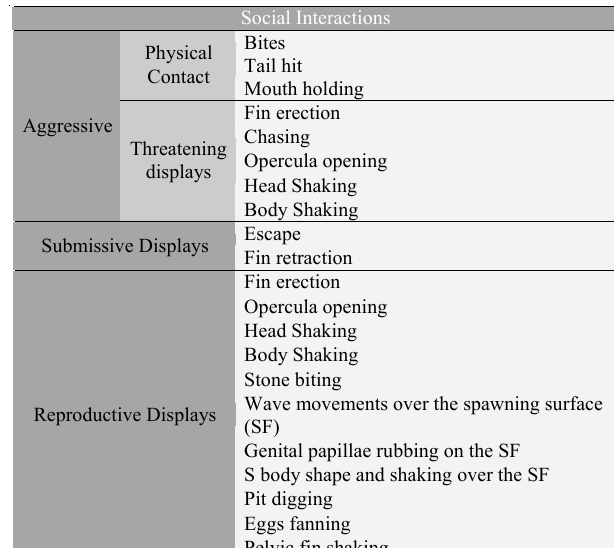
Table 4. Ethogram outlining the aggressive, submissive and reproductive behavioral repertoire of Cichlasoma dimerus